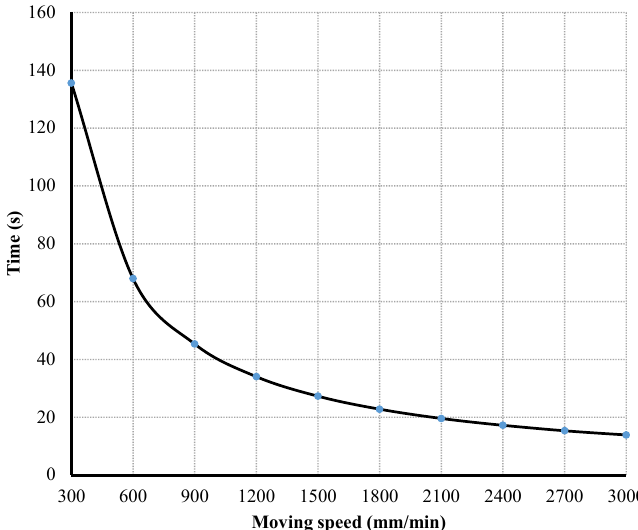
Figure 9. Printing duration following the moving speed. Experimentally, the printing speed should be at around 1200 mm/min for the smooth surface layer.